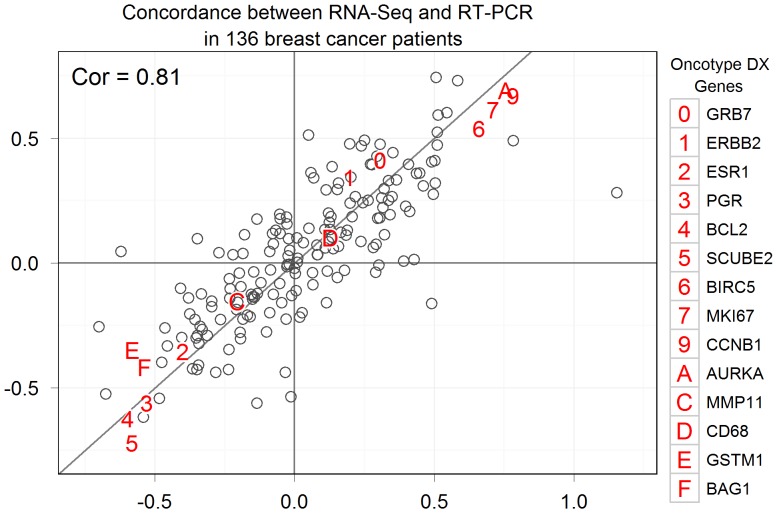
Scatter plot of recurrence risk hazard ratios of RNA sequences.RT-PCR results versus RNA-Seq results. Each point represents a distinct RNA. Genes in the 21-gene breast cancer recurrence risk assay are marked with alphanumeric symbols.